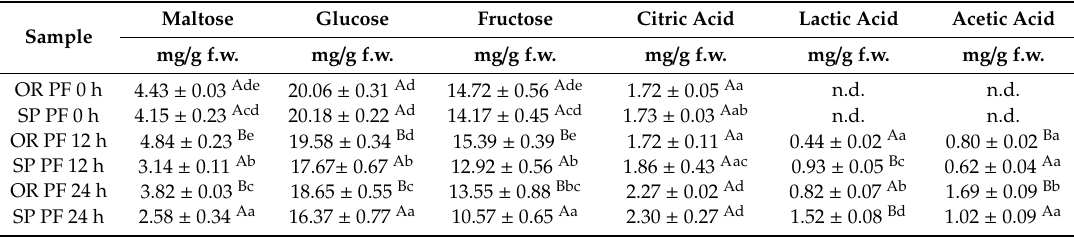
Table 5. Carbohydrates and organic acids of gluten free mu ffi ns manufactured with OR and SP sourdoughs at di ff erent fermentation